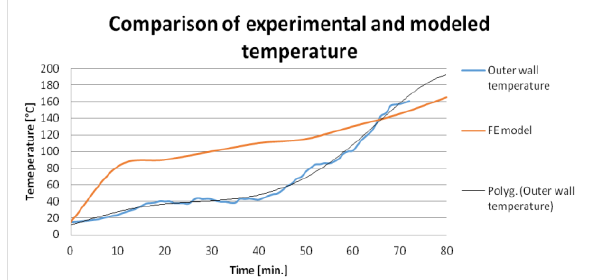
Fig. 4 . Experimental and FE model